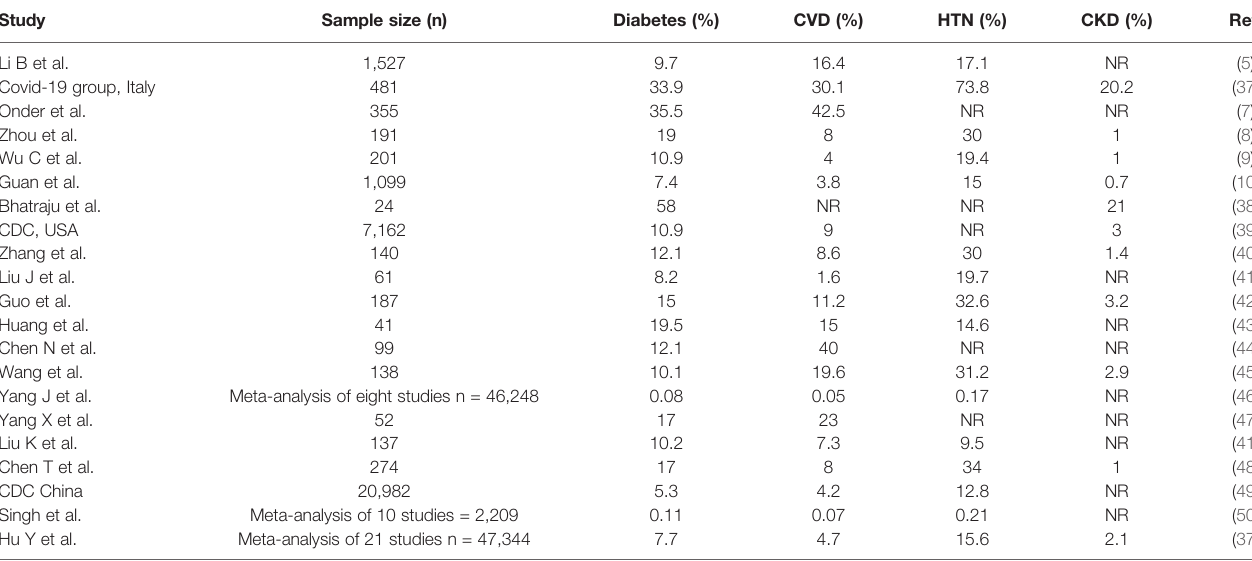
TABLE 1 | Prevalence (%) of comorbidities in COVID-19 infected patients.